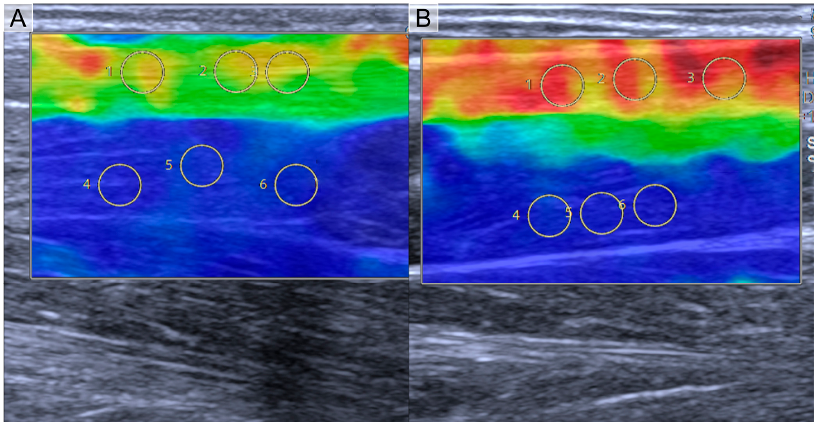
Figure 5. Color-coded mapping shows lower sti ff ness in SWE assessment in a female handball player ( A , median SWS 10.31 m/s visualized as mostly green) and a female sprinter ( B , median SWS 12.31 m/s visualized as mostly orange/red).